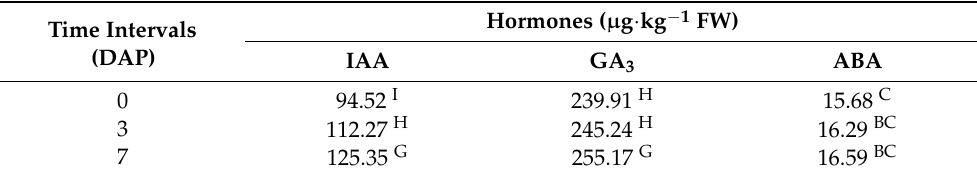
Figure 3. The data represent mean values ± SD of IAA content under normal pollination type ( A ) and forced pollination type ( B ) (LSD0.05 = 18.084), GA 3 content under normal pollination type ( C ) and forced pollination type ( D ) (LSD 0 . 05 = 24.162), and ABA content under normal pollination type ( E ) and forced pollination type ( F ) (LSD 0 . 05 = 4.284) at different times from 0 to 84 days after pollination for tissue culture and offshoot-derived date palms of 13-year-old palm trees. Table 2. Mean values of indole acetic acid (IAA), gibberellin (GA 3 ), and abscisic acid (ABA) contents at different time intervals (from 0 to 84 days after